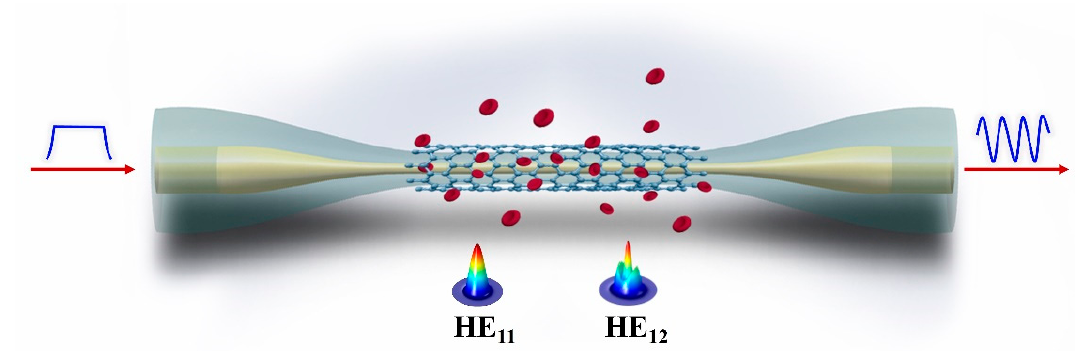
Figure 1. Schematic diagram of the proposed microfiber-based hemoglobin biosensor.